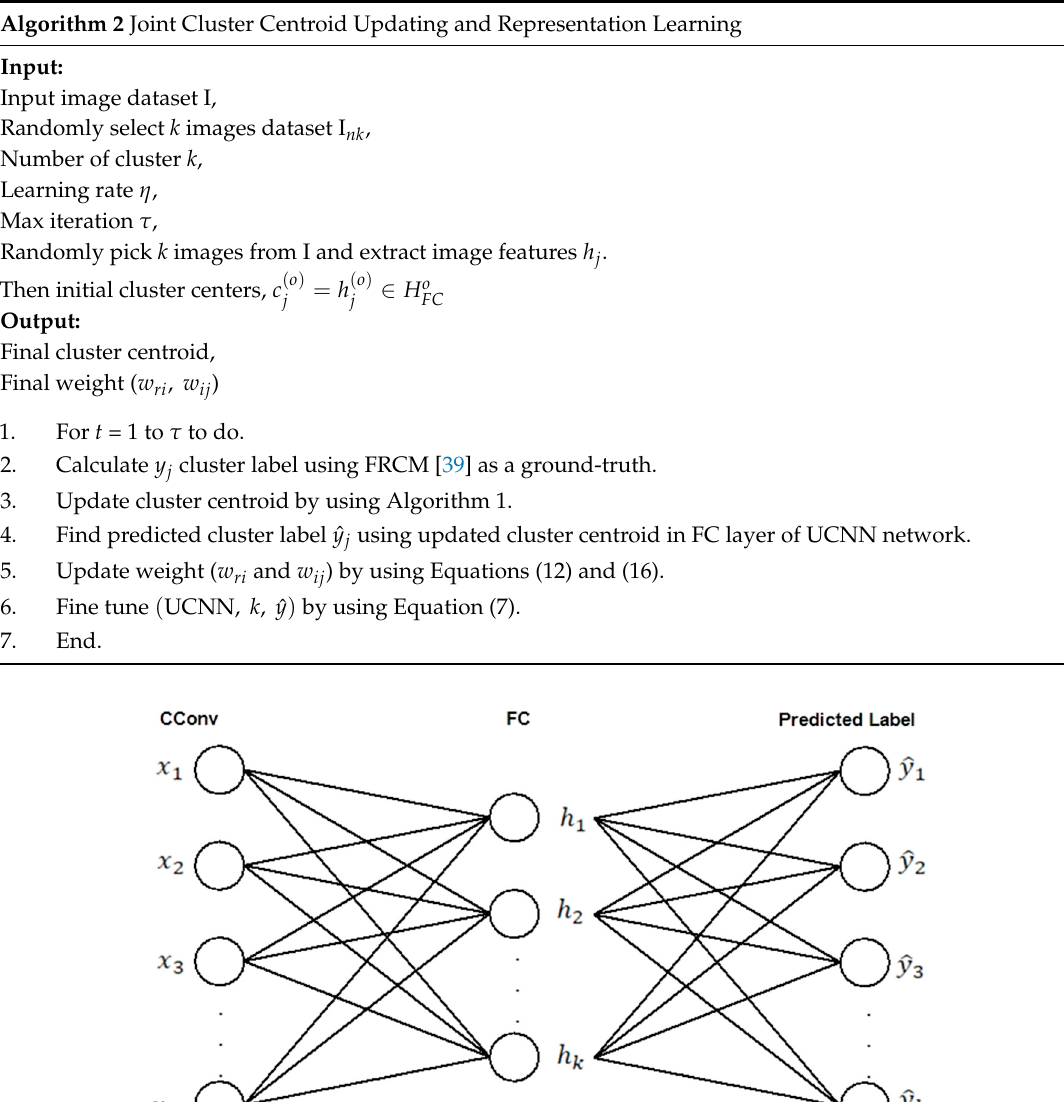
Table 1. Description of Datasets. Dataset